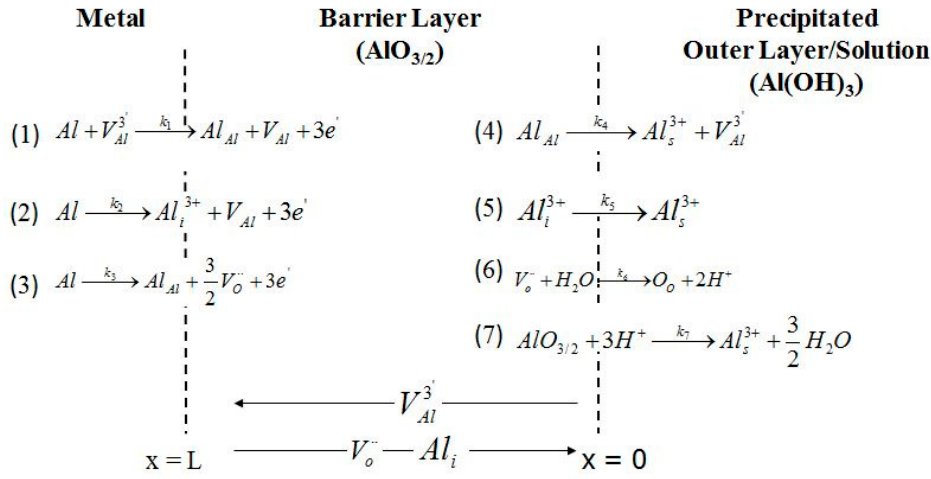
= cation vacancy on the metal Al = interstitial cation, i